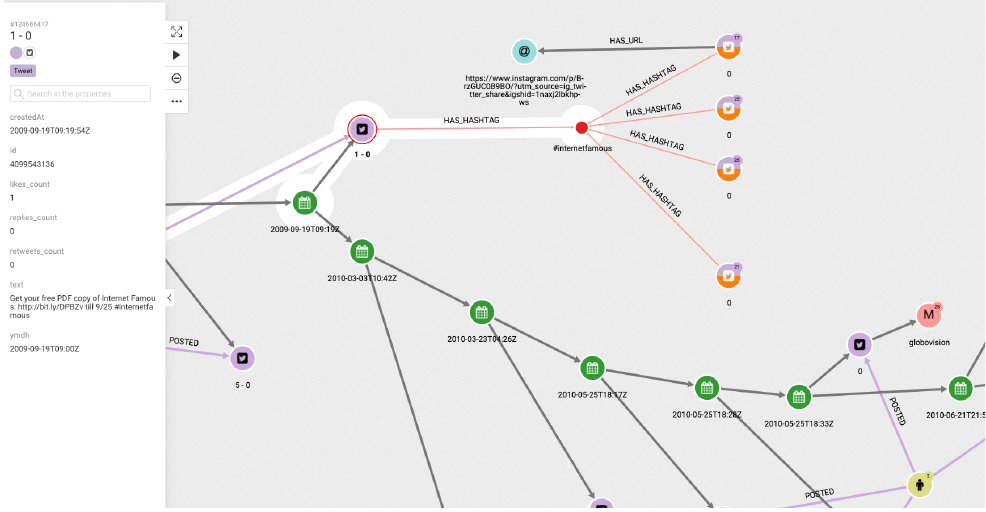
Figure 5. Tweets and hashtags in a